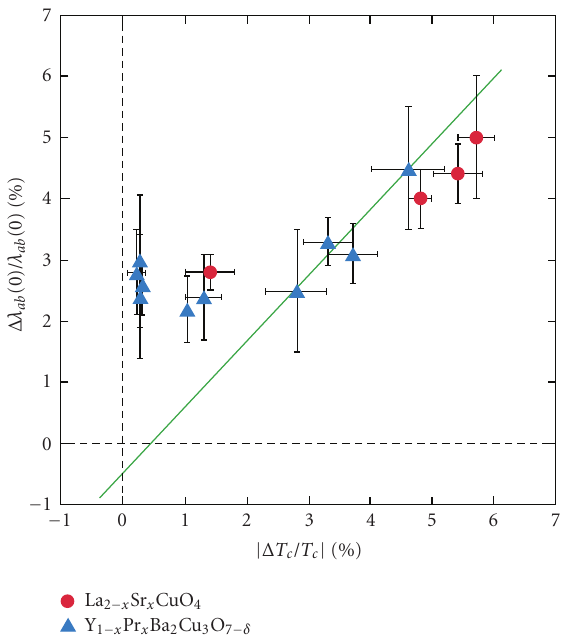
Figure 5: Plot of the OIE shift Δ λ ab (0) /λ ab (0) versus the OIE shift | Δ T c /T c | for La 2 − x Sr x CuO 4 and Pr x Y 1 − x Ba 2 Cu 3 O 7 − δ using di ff erent experimental techniques and types of samples. The data are summarized in [16, Table 1]. The solid line corresponds to model calculations of the OIE on Δ λ ab (0) /λ ab (0) obtained from the theoretical results for the average gap [43–46, 69], after [43–46].